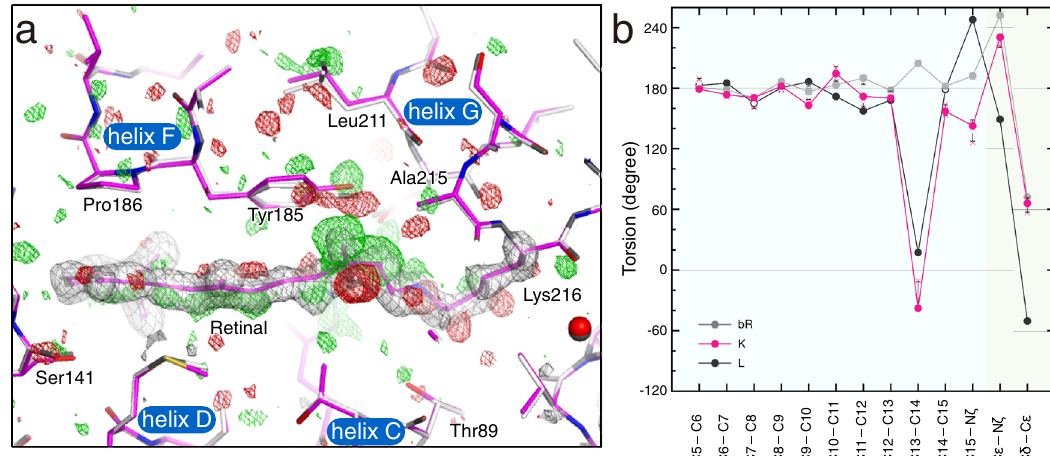
Fig. 2 Details of the distorted retinal conformation. a S-shaped polyene backbone of retinal viewed from an upper part of Fig. 1b. The maps are shown in the same manner as in Fig. 1b. b Torsion angles along the retinal polyene chain in the K structure (7XJC) are plotted in magenta. The standard deviations, which were calculated from three structures, are indicated as error bars on the mean values shown as hollow circles. The values for respective structures are shown as crosses. The values can be found in Supplementary Table 4. Those for the ground state structure in this work (7XJD) and a recent L structure 16 are plotted in gray and black, respectively. The black horizontal lines indicate angles with local minimum energies for the respective torsions.